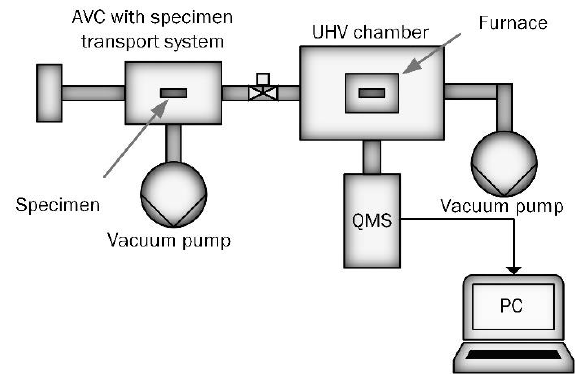
Figure 3. Schematic view of the thermal desorption spectroscopy apparatus.